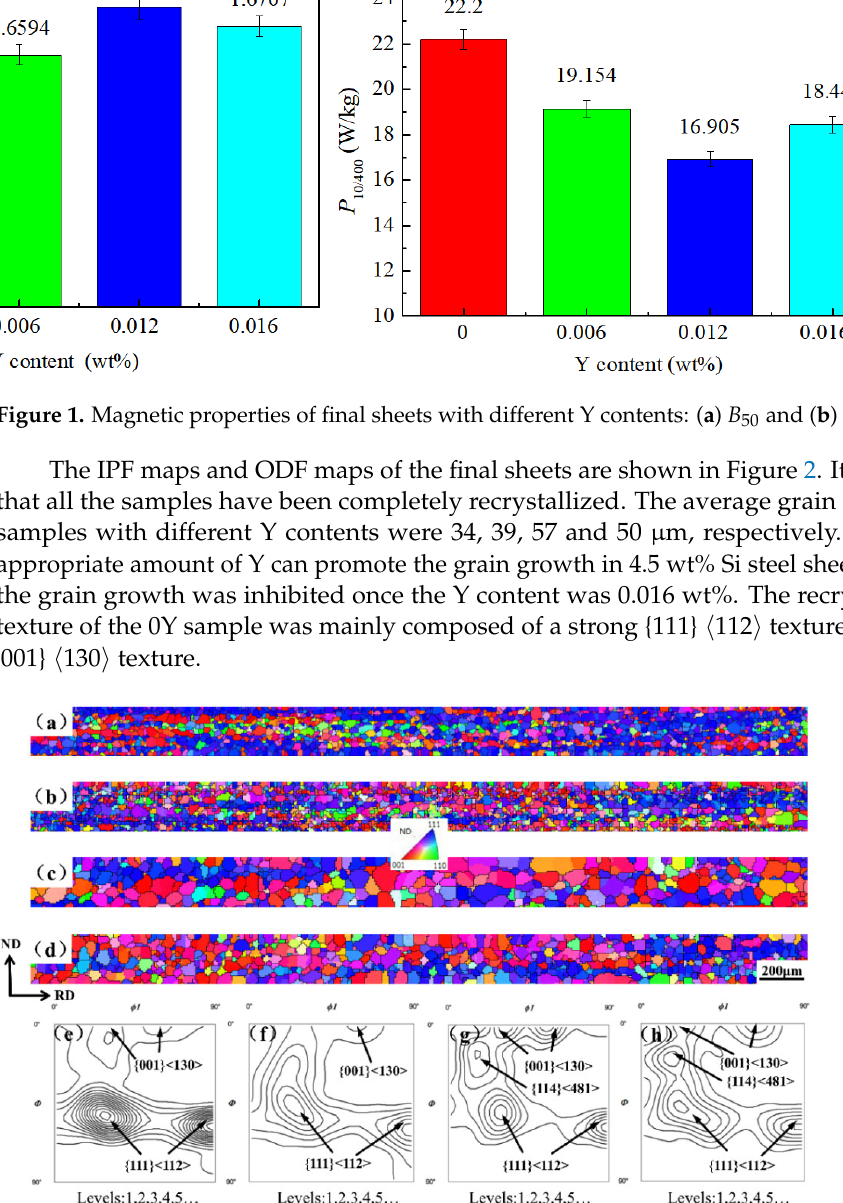
Figure 2. IPF maps, ODF at 𝜑 (cid:2870) = 45° section of final sheets with different Y: ( a , e ) 0Y; ( b , f ) 0.006Y; ( c , g ) 0.012Y; and ( d , h ) 0.016Y.